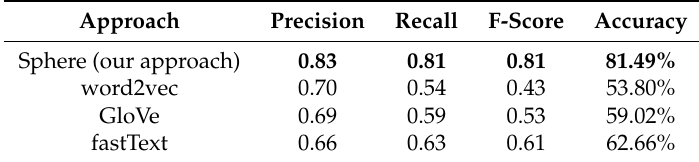
Table 7. Antonym/synonym discrimination